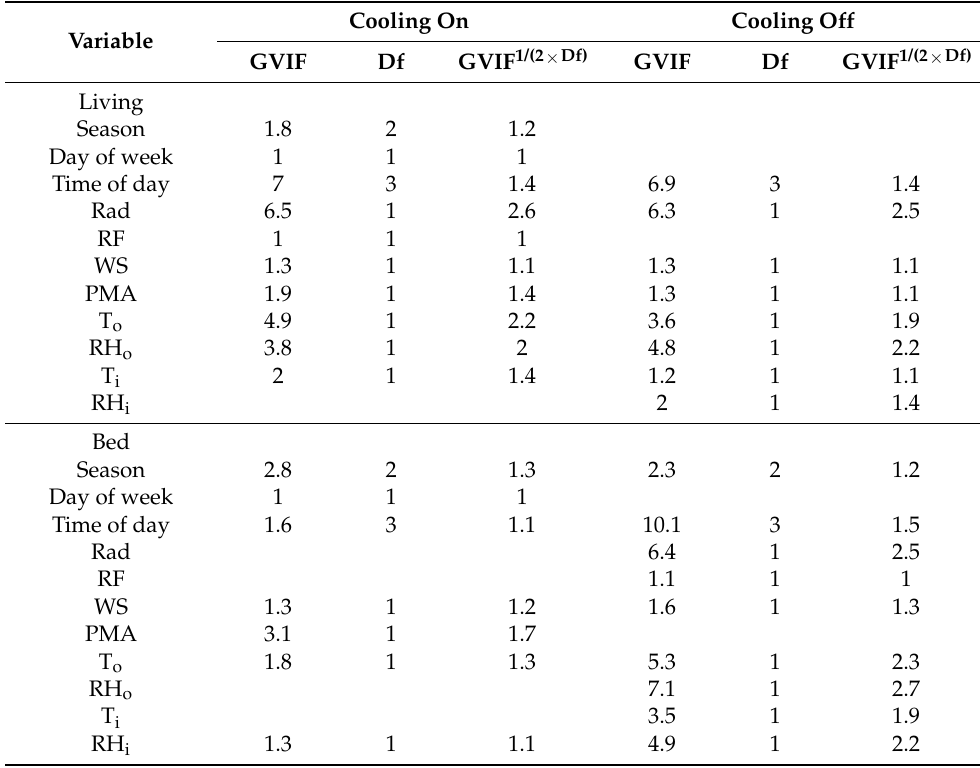
Table 4. GVIF analysis results from A/C Cooling on and off models.